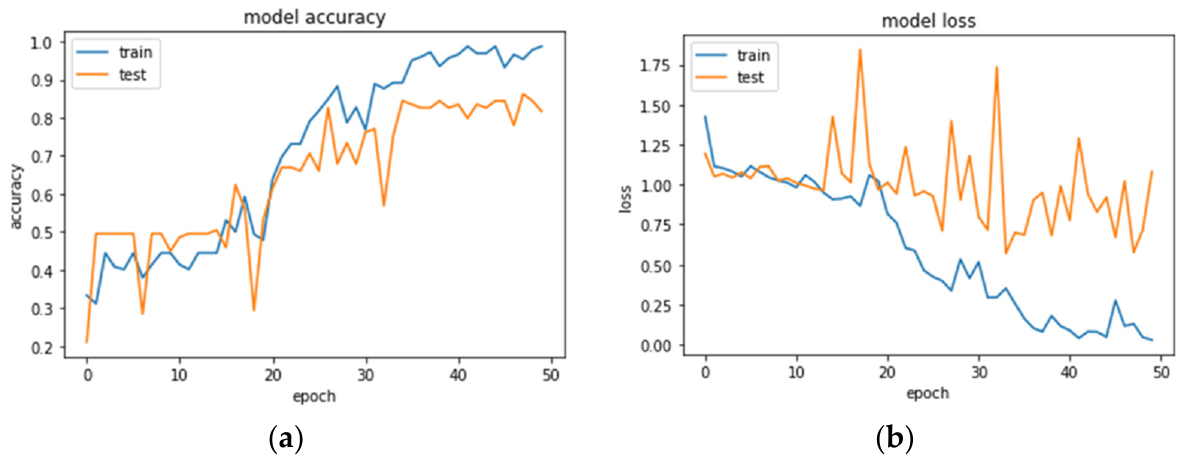
Figure 8. Training and testing of AlexNet + IDA model: ( a ) accuracy, ( b )